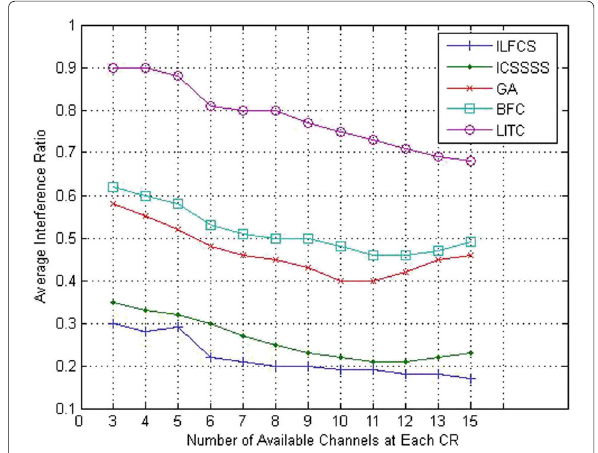
Fig. 12 Average interference ratio under different number of available channels. The results of different simulation experiments to measure average interference ratio at different numbers of available channels for the BFC, LITC, GA, ICSSSS, and the ILFCS are